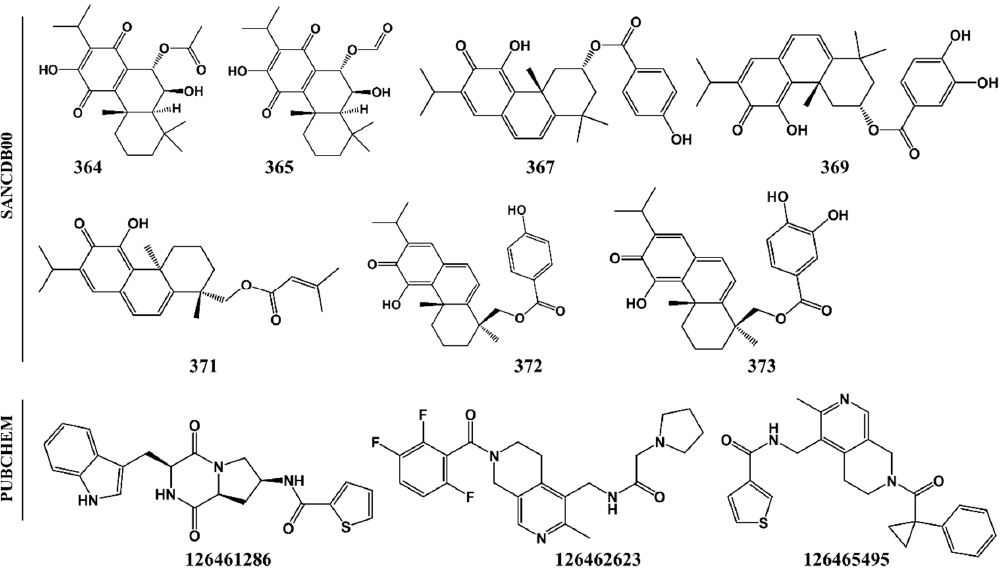
Figure 3. 2D representation of identified South African Natural Compound Database (SANCDB) hits and analog compounds from PubChem.